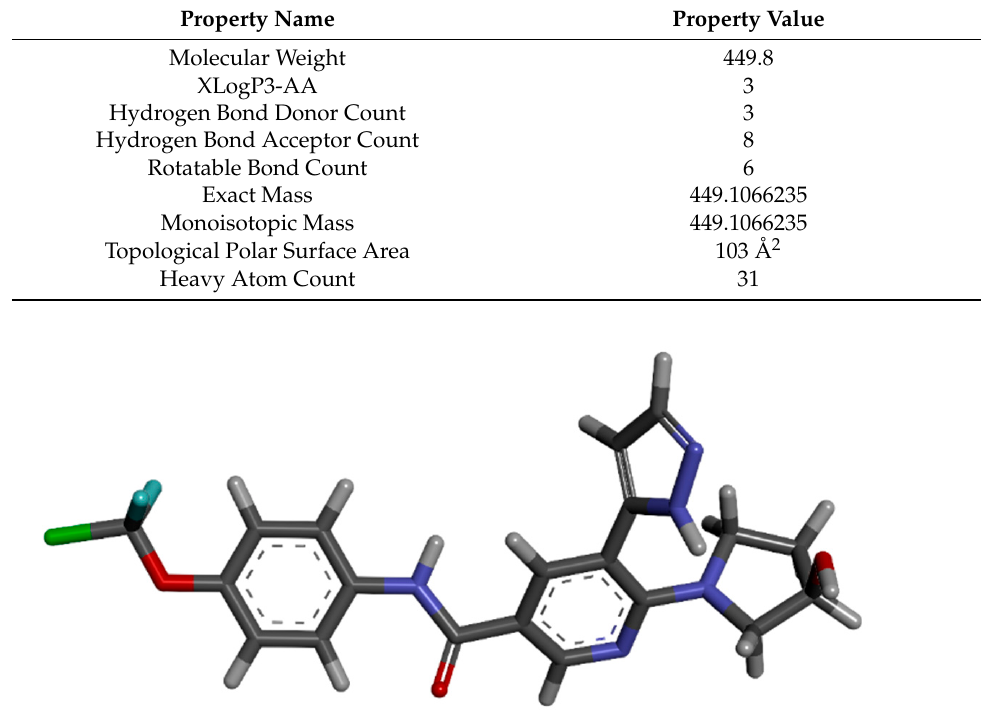
Figure 4. The 3D structure of asciminib from Puchem.